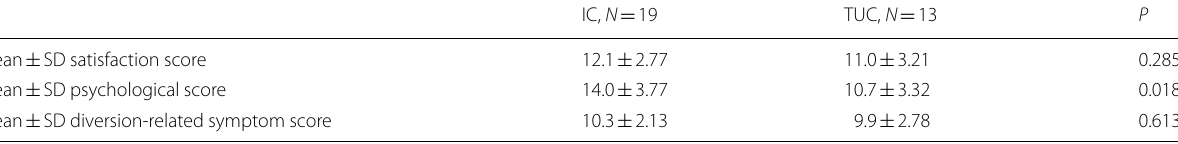
IC ileal conduit, TUC transuretero-cutaneostomy, SD standard deviation All statistical analyses in this table used independent t test analysis